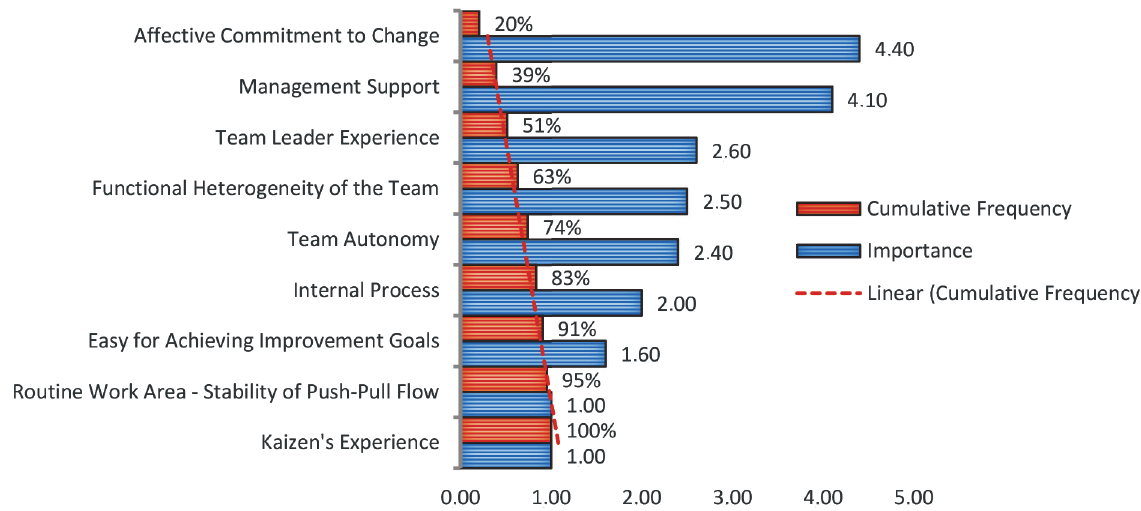
Figure 7. Most relevant attitudes of peoples to achieve